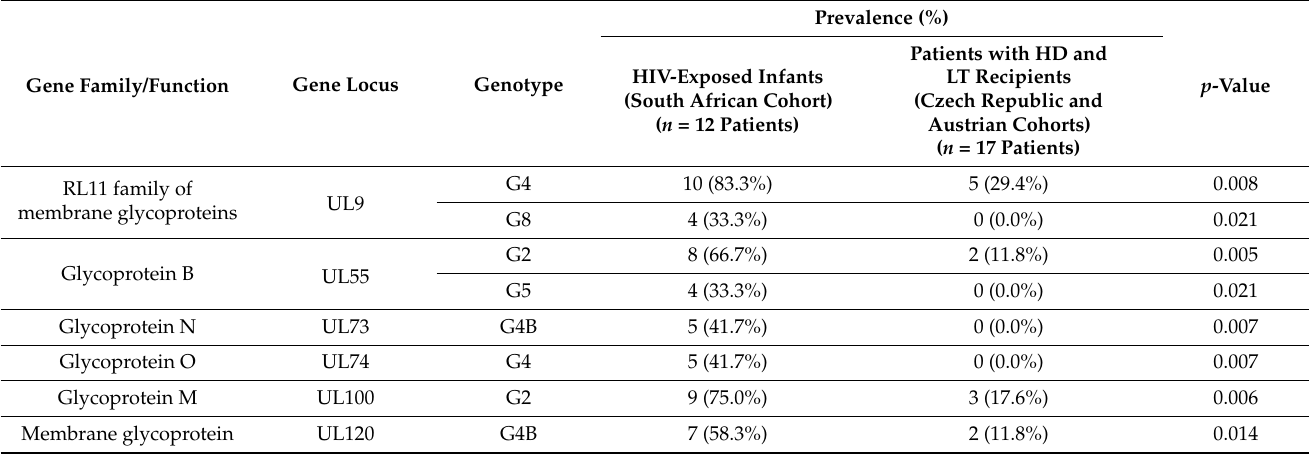
Table 2. Difference in genotype prevalence between HIV-exposed infants with HCMV pneumonia, compared with patients with hematological disorders (HD) and lung transplant (LT) recipients. Prevalence Gene Locus Genotype